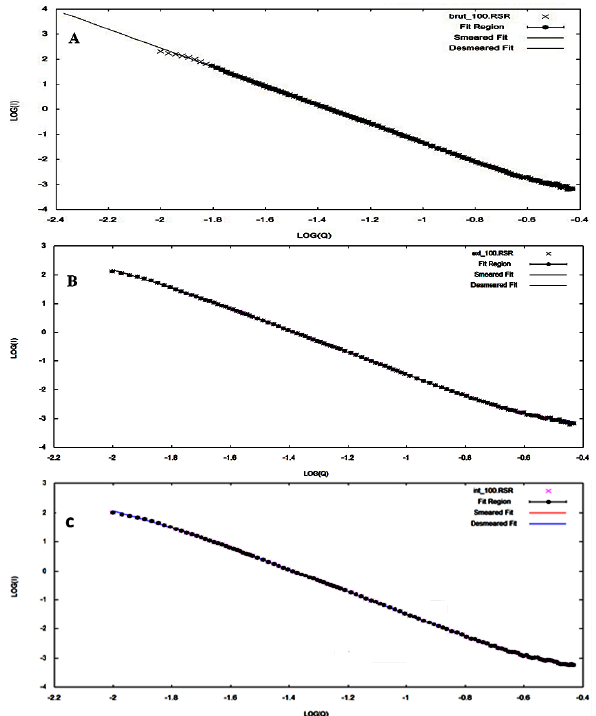
Figure 5: Small-angle-X-ray scattering profiles of the three samples. Data plotted as a log (I (q)) vs. log (q). (A) sample S1: untreated phosphate dust. (B) sample S2: calcium phosphate dust from the outside of filter. (C) sample S3: calcium phosphate dust from the inside of